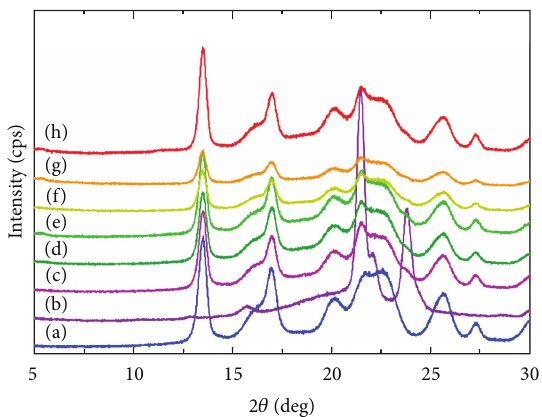
Figure 4: XRD patterns of (a) pure PHB, (b) pure PCL, and (c) 80PHB/20PCLandPHB/PCL/stearateMg-AlLDHnanocomposites with (d) 0.25, (e) 0.5, (f) 1, (g) 1.5, and (h) 2wt% stearate Mg-Al LDH content.